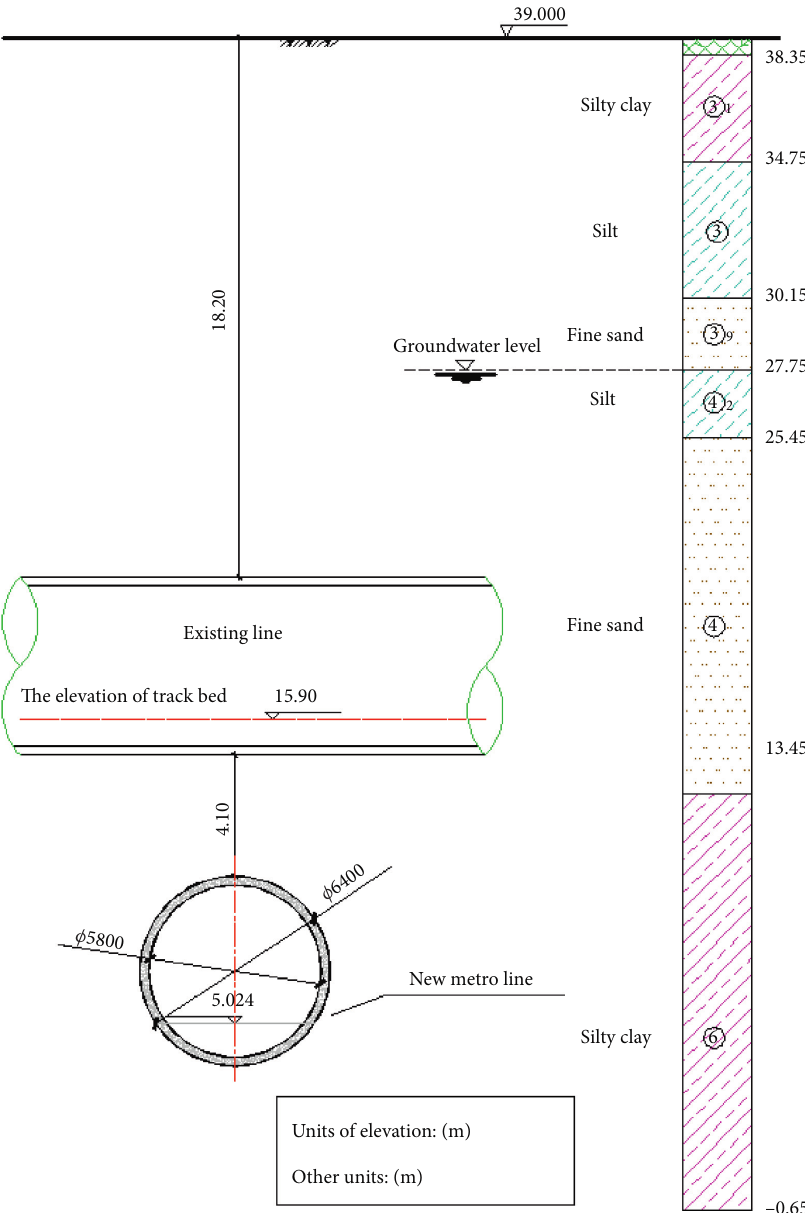
Figure 4: Cross section of undercrossing